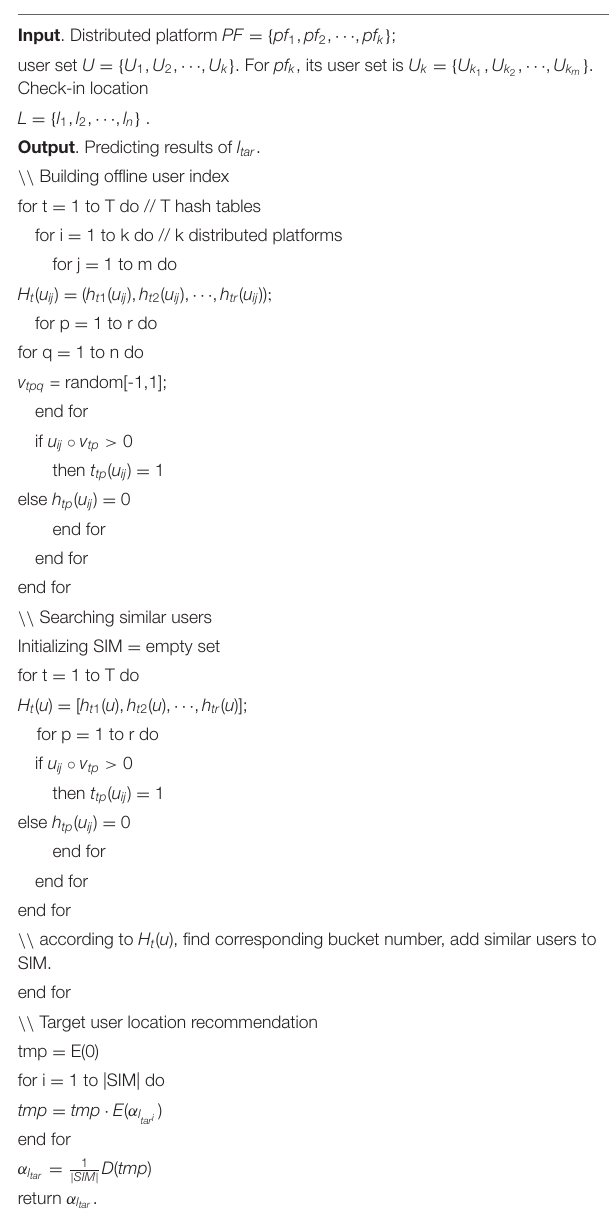
Algorithm 1: MELSH-based P 3 OI